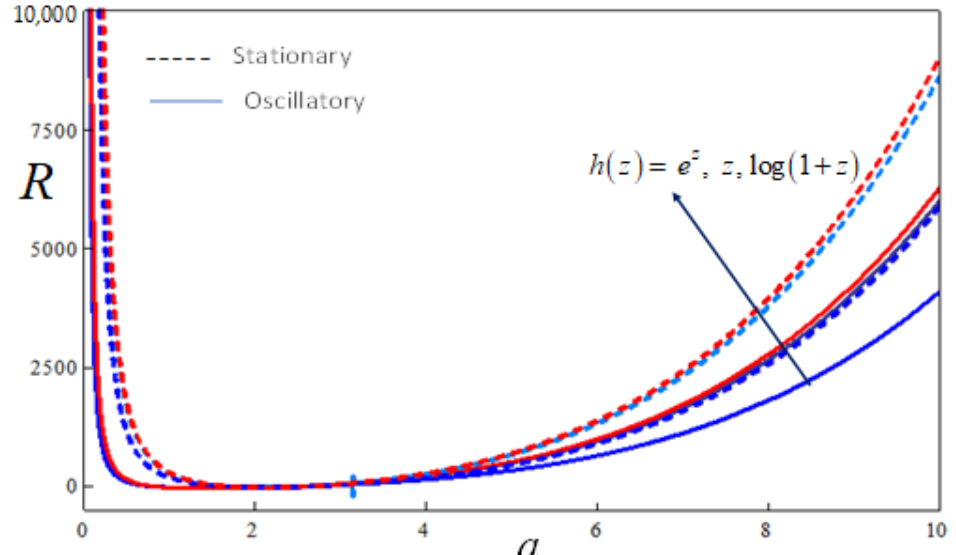
Figure 9. Plot of R verses a for different cases of gravity variation when Le = 0.5, Rs = 10, Da = 0.1, ξ = 0.5, η = 0.5 and δ = 0.5.